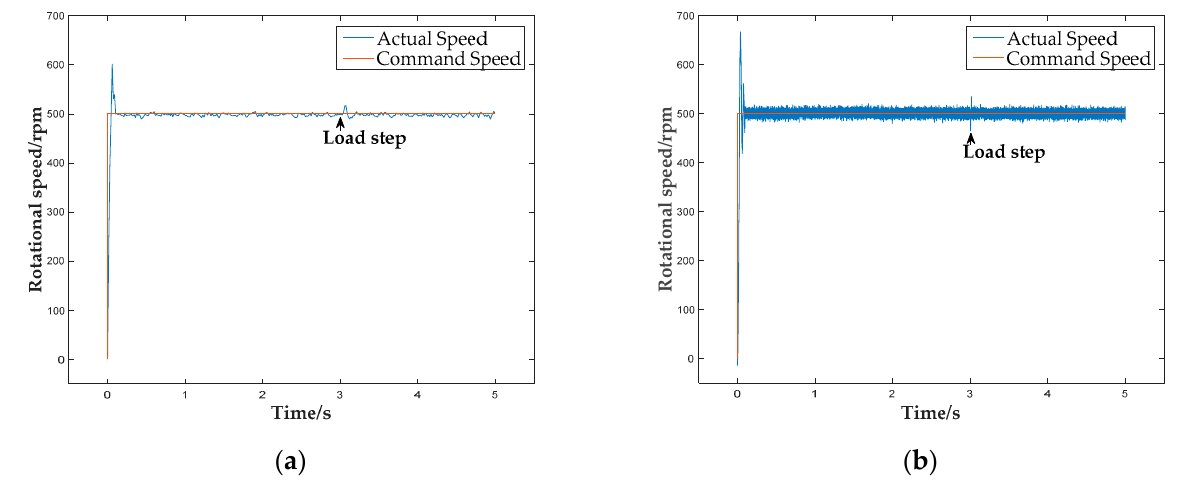
Figure 4. The simulation and experimental results of the motor system. ( a ) The simulation results. ( b ) the experimental results.